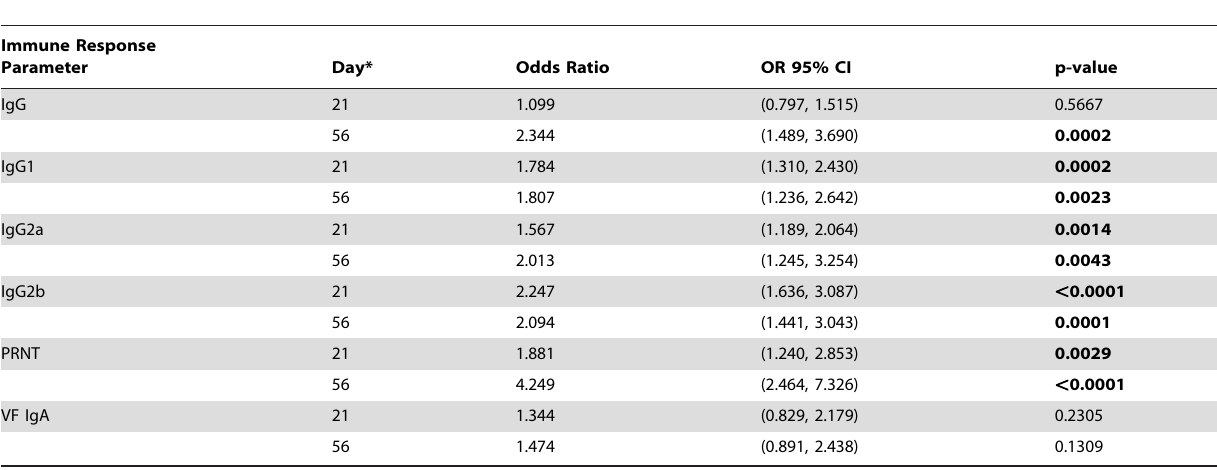
*Table represents data from all groups for day 21, and only for animals receiving two vaccinations for day 56.